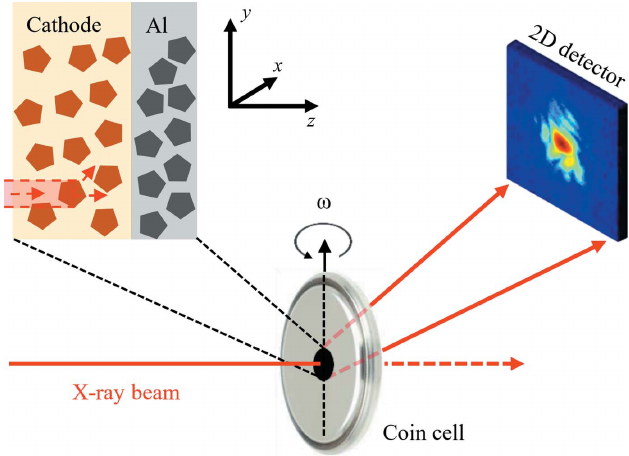
Figure 1 Schematic of the depth-resolved Bragg CDI approach. Before the measurements, the axis of rotation of the instrument ( ! ) is aligned to intersect with the focused X-ray beam. The sample (in our case, a battery cathode in a coin cell) is searched for particles that have bright and isolated Bragg peaks on the 2D detector. We use the right-hand coordinate system with the z axis along the direction of the X-ray beam and the y axis aligned with the sample rotation axis.